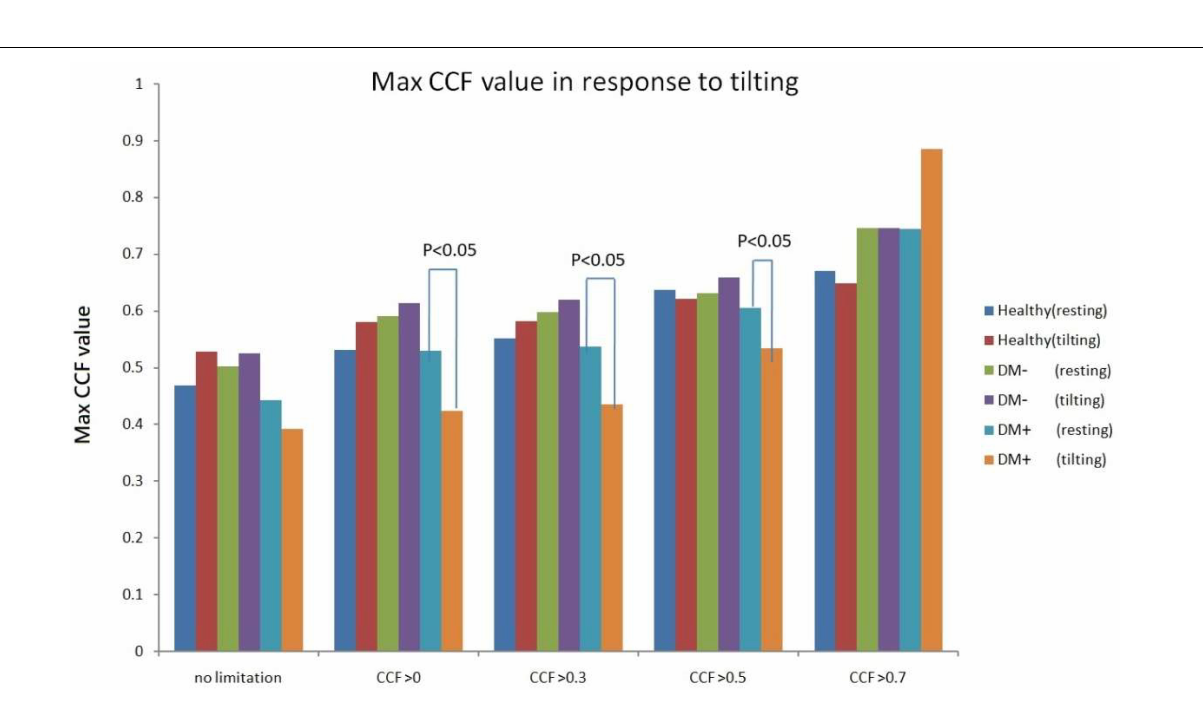
Frontiers in Neuroscience |